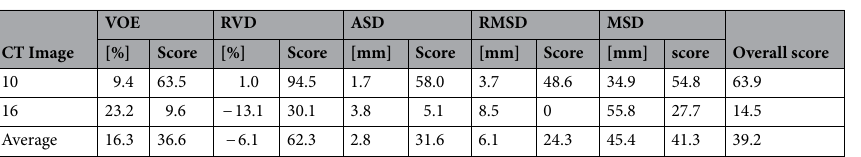
Table 9. The results of segmentation on cases with extensive tumors.